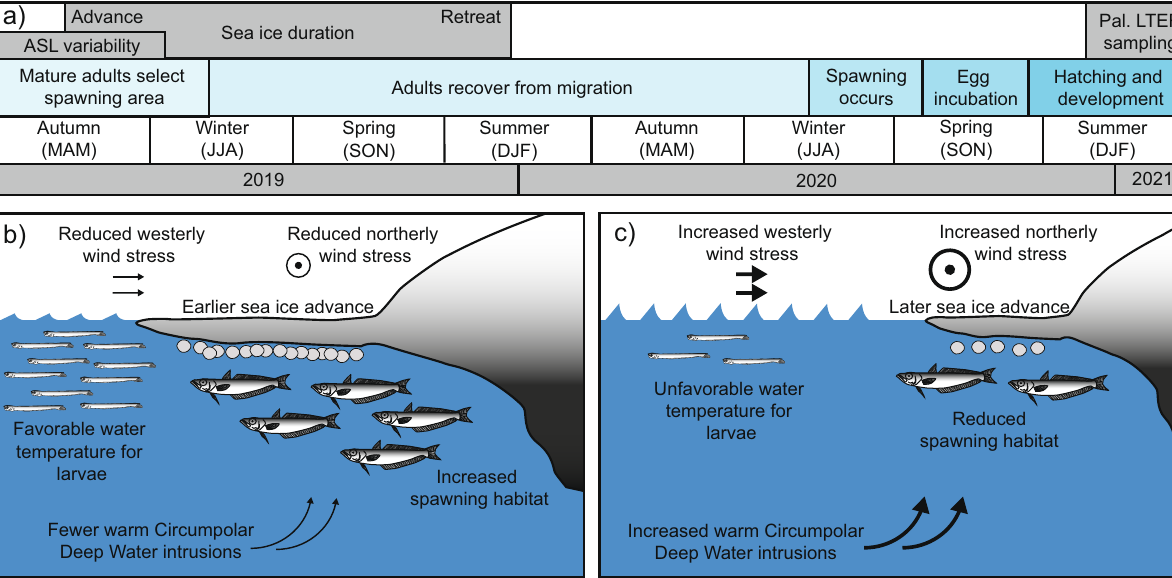
Fig. 3 Timeline with optimal and suboptimal conditions for Antarctic Silver fi sh reproduction near the western Antarctic Peninsula (WAP). a A timeline of Antarctic Silver fi sh skip-spawning behavior and proposed relationships with Amundsen Sea Low (ASL) variability and sea ice advance. b , c Schematic of b optimal and c suboptimal environmental conditions for larval and spawning adult Antarctic Silver fi sh near the WAP. Northerly and westerly wind stresses are both modulated by the ASL strength (i.e., RCP) and location (i.e., latitude). Intrusions of Circumpolar Deep Water (CDW) are associated with anomalous westerly winds; sea ice advance is in fl uenced by a combination of wind stress, CDW, precipitation, and other factors; and near-surface water temperatures are determined by atmospheric heat, CDW intrusions, ice melt, and other